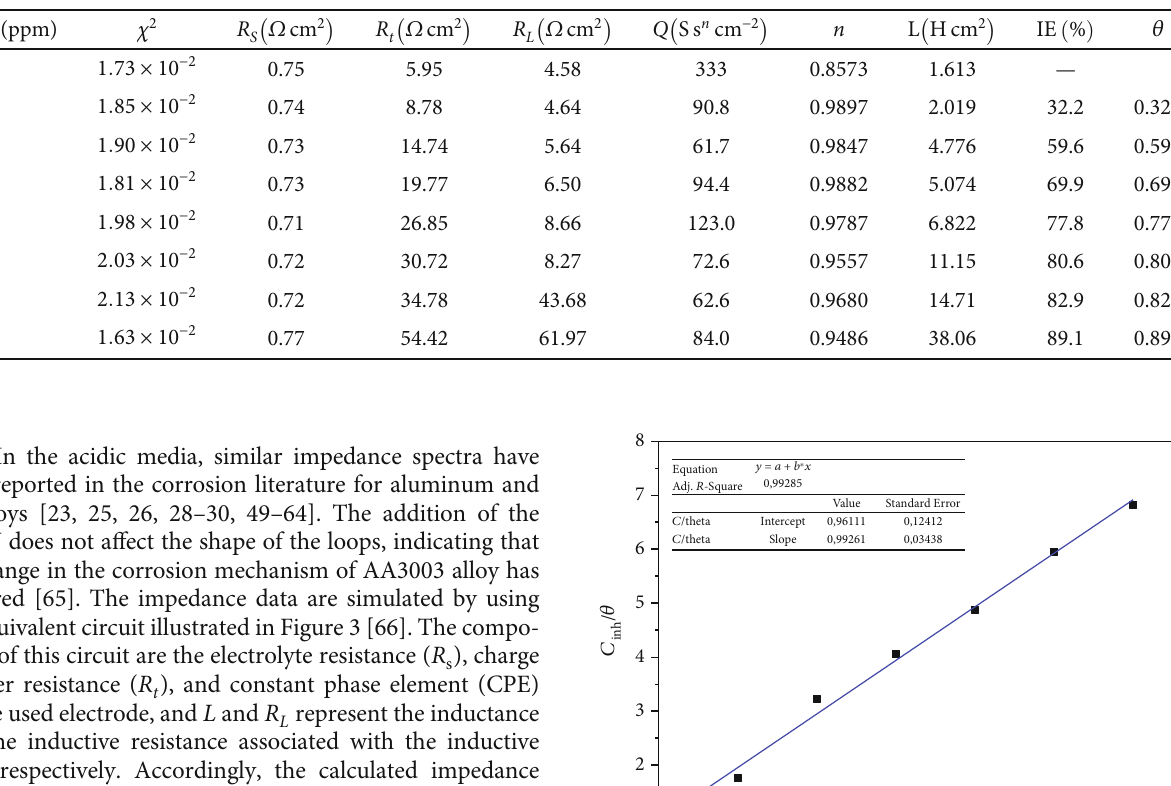
Table 5: Electrochemical impedance parameters of AA3003 alloy in 1 M HCl medium without and with addition of OMW inhibitor at di ff erent concentrations (at 298 K).